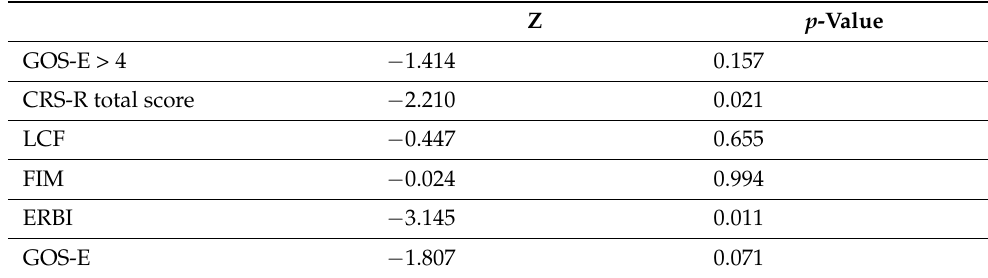
Table 3. Admission–discharge